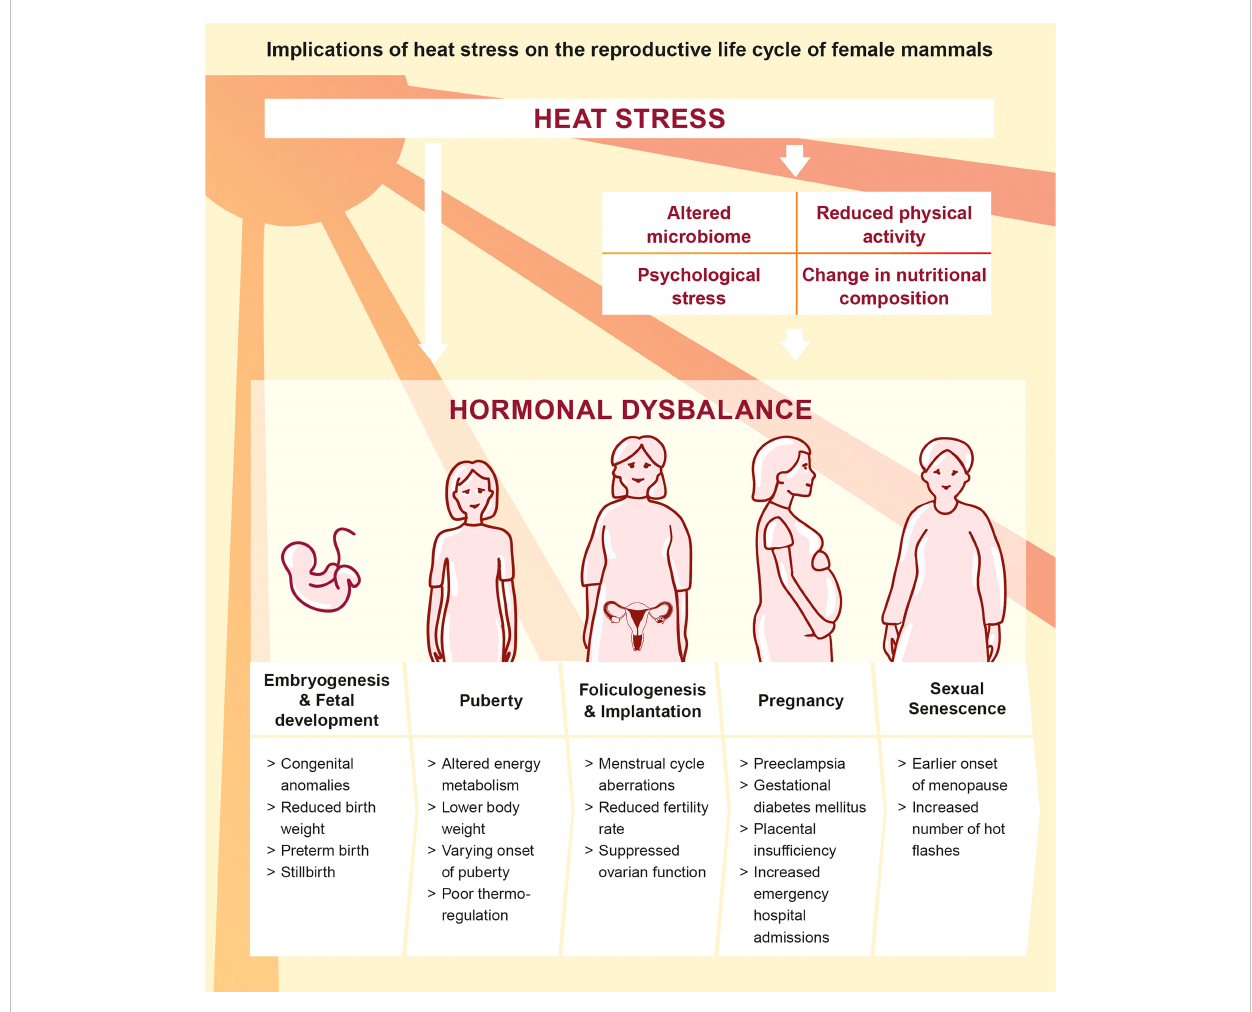
FIGURE 2 Direct and indirect implications of heat stress on the reproductive life cycle of female mammals (5, 26, 27, 37 –